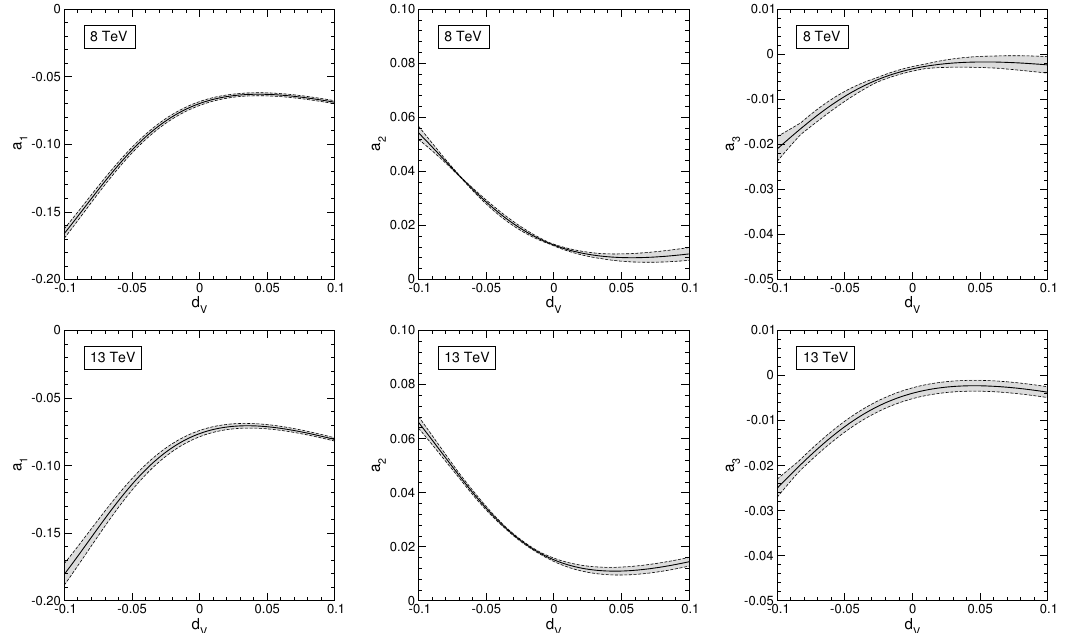
Figure 4 . Dependence of the (cid:12)rst Fourier coe(cid:14)cients in (2.1) on a possible top chromomagnetic moment d V , for CM energies of 8 TeV and 13